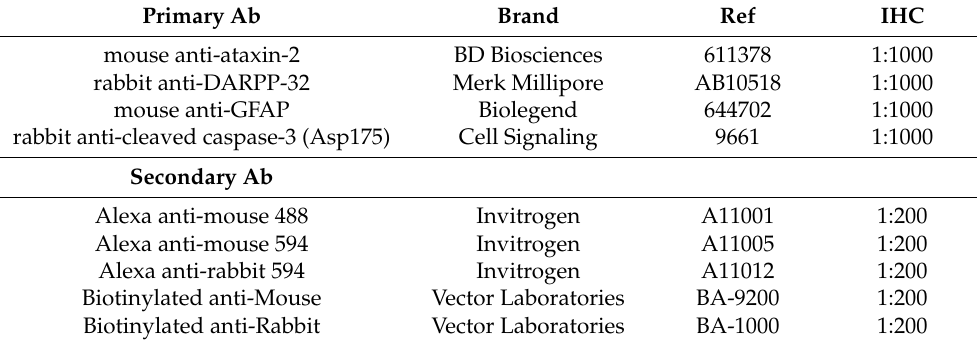
Table 1. Primary and secondary antibodies used in immunohistochemistry